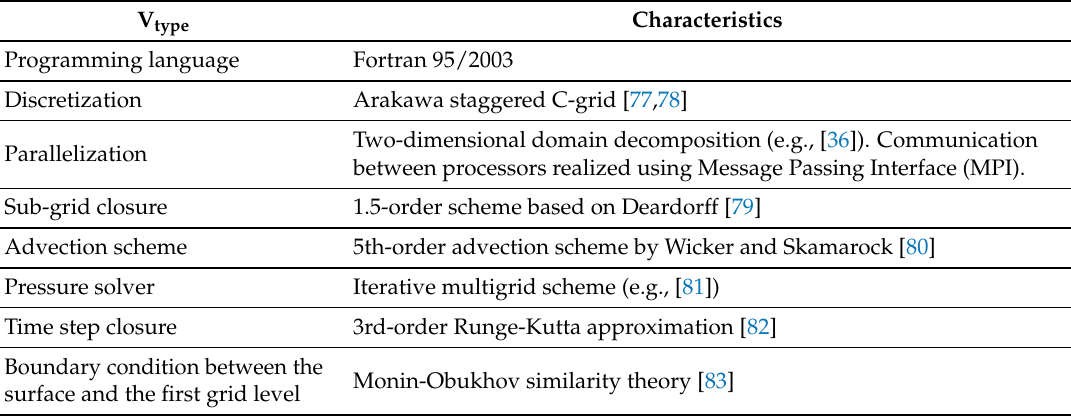
Table A1. Technical specifications for the simulations conducted with the LES model